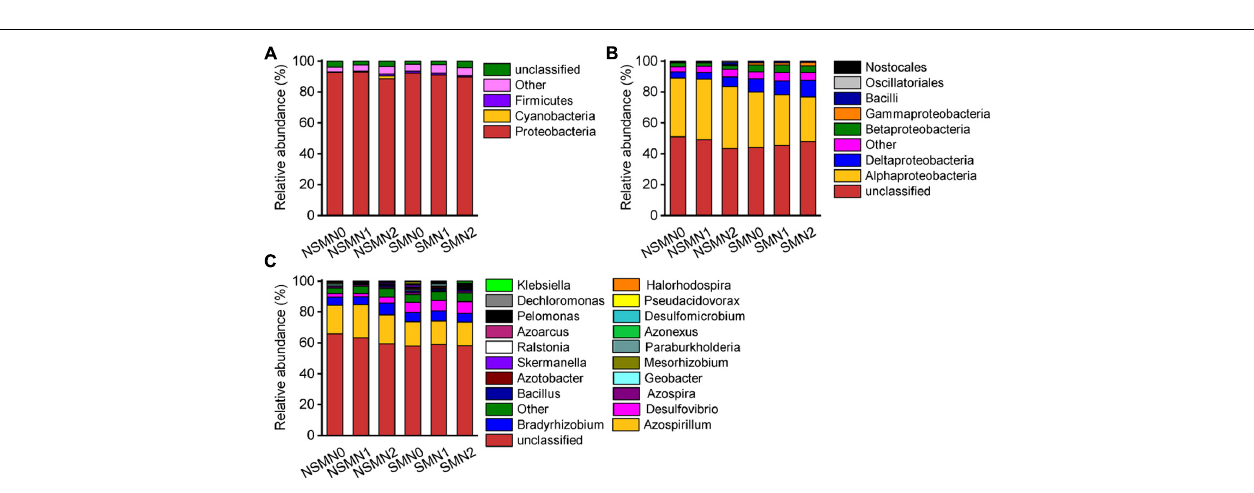
and Desulfovibrio were high in all treatments ( Figures 4B,C